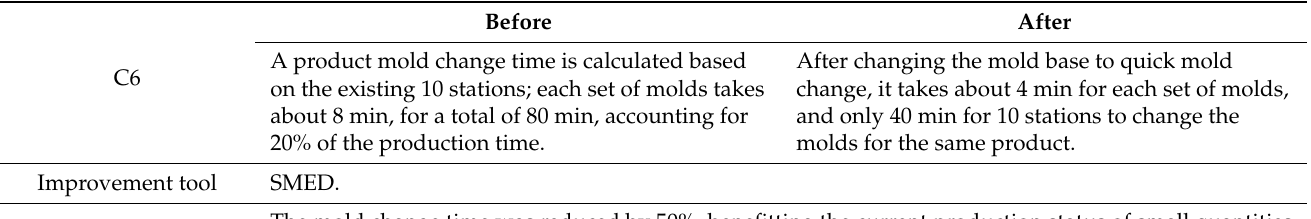
Table 10. C6 improvement project and its improvement effect (before and after).